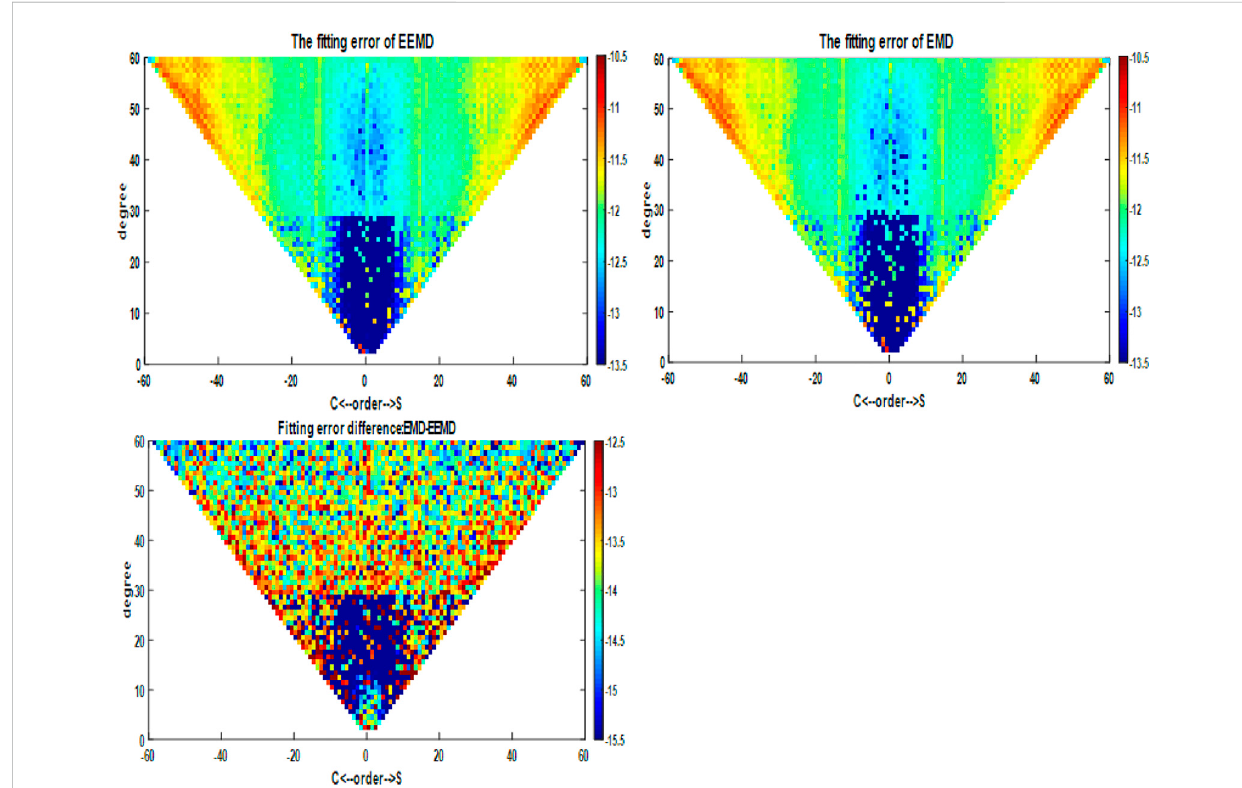
FIGURE 6 The fi tting errors of GRACE SH coef fi cients after fi ltering by EMD and EEMD and their differences (in